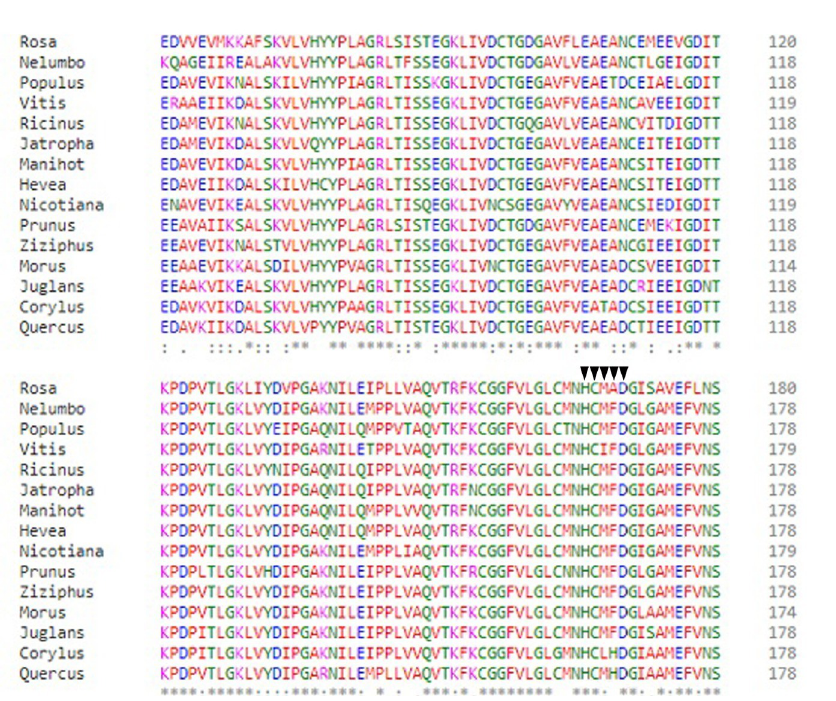
Fig 1. Multiple sequence alignment amino acids of TDAT gene with other plants. The HXXXD motif was indicated with the ▼ symbol above the motif letters.